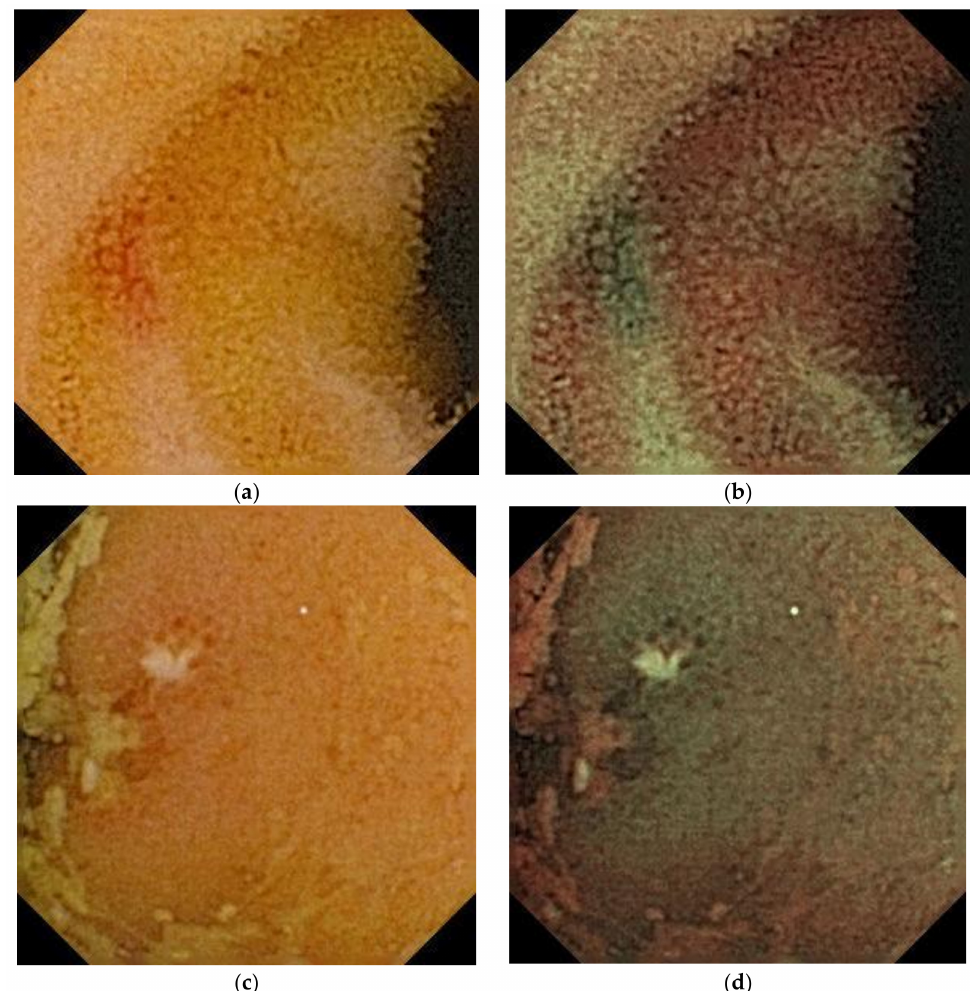
Figure 2. Capsule endoscopy images of small intestinal lesions: angioectasia ( a , b ) and ulcer/erosion ( c , d ). WLI ( a , c ), CC ( b , d